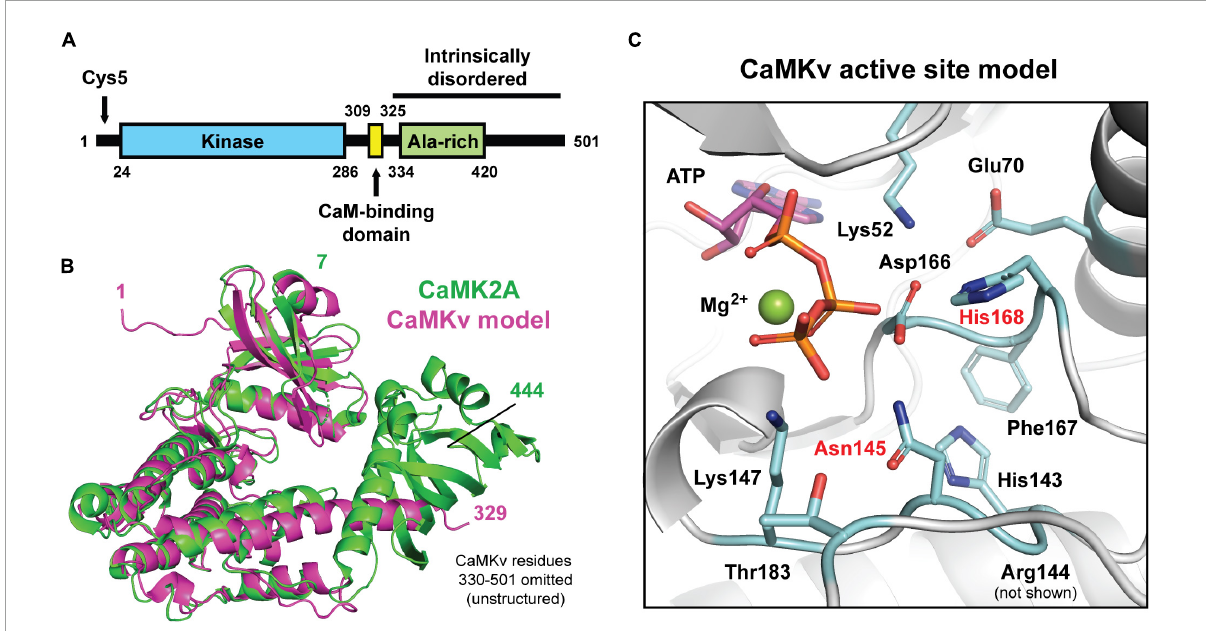
FIGURE1 Predicted secondary and tertiary structure of calmodulin kinase-like vesicle-associated (CaMKv). (A) Domains of CaMKv. The intrinsically disordered region was predicted using the PONDR (Predictor of Natural Disorder Region) program. The entire sequence from residues 325–351 had PONDR scores ranging from 0.8 to 1.0. (B) Structural alignment (C α r.m.s.d = 1.21 Å) of the full-length crystal structure of human CAMK2A (green; PDB: 3SOA) and a predicted model of residues 1–329 of human CaMKv derived from the AlphaFold Protein Structure Database (magenta; entry Q8NCB2). Unstructured residues 330–501 of CaMKv were omitted. (C) Close-up view of the predicted active site of CaMKv with modeled placement of ATP and Mg 2 + based on an alignment to a crystal structure of CAMK2A bound to ATP (PDB: 6XBX). Residues located at positions that are important for catalysis in protein kinases are colored blue. Residues labeled in red differ from those typically found in active